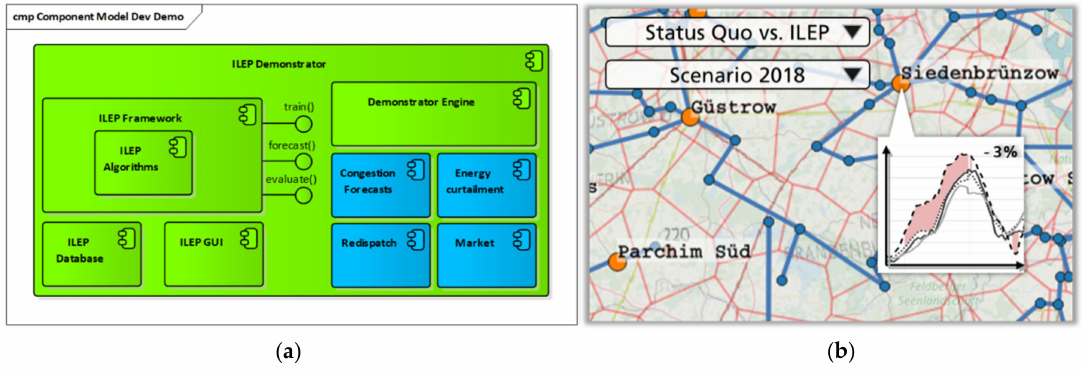
Figure 11. ( a ) Components of the development and demonstration system (left); ( b ) user interface mockup